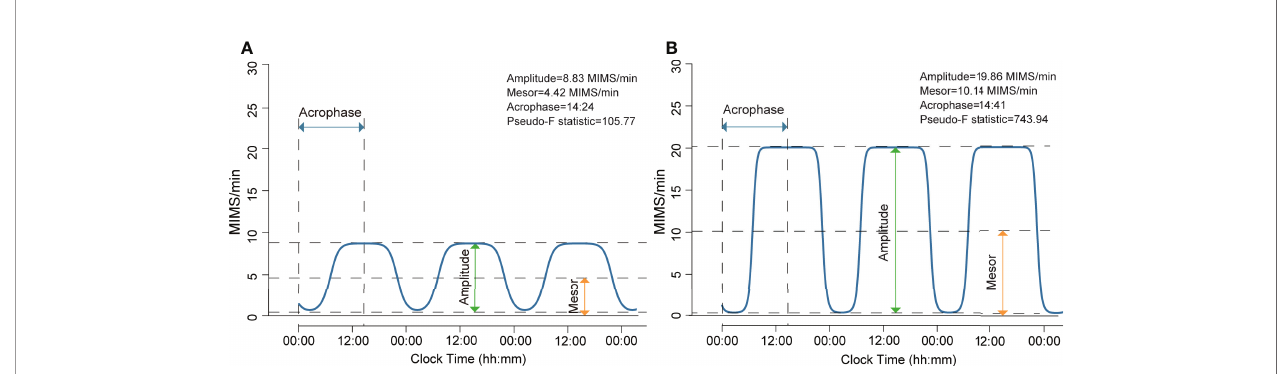
FIGURE 1 | Rest-activity rhythm from participants with and without general obesity generated using extended cosinor model. (A) This participant had a BMI of 44.7 kg/m 2 and was in the lowest quartiles of amplitude and mesor, indicating a lower magnitude of the rest-activity rhythm and a lower rhythm-adjusted average activity level. This participant exhibited a normal phase of rest-activity rhythm, as shown by the activity rhythm peaking at 14:24, and did not have distinct rest-activity periods as indicated by low rhythm robustness (pseudo-F statistic). (B) This participant had a BMI of 20.3 kg/m 2 and was in the highest quartiles of amplitude and mesor, indicating a higher magnitude of the rest-activity rhythm and a higher rhythm-adjusted average activity level. This participant exhibited a normal phase of rest- activity rhythm, as shown by the activity rhythm peaking at 14:41, and had distinct rest-activity periods as indicated by the high value for rhythm robustness (pseudo-F